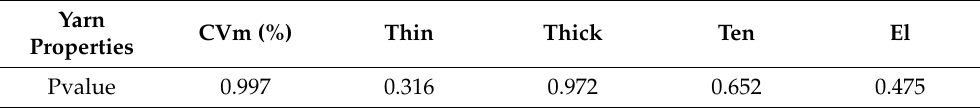
Table 8. One-way ANOVA test for yarn properties of blends.